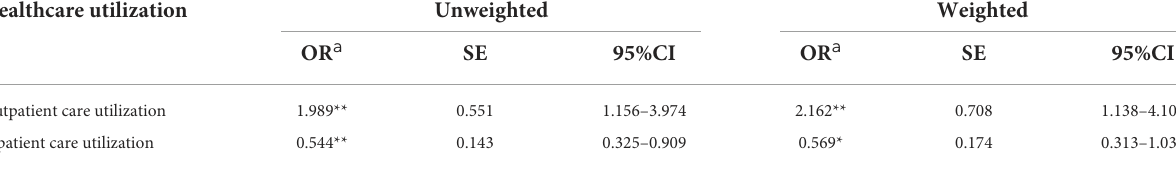
TABLE 2 Effects of community-based diabetes examination on healthcare utilization (logit